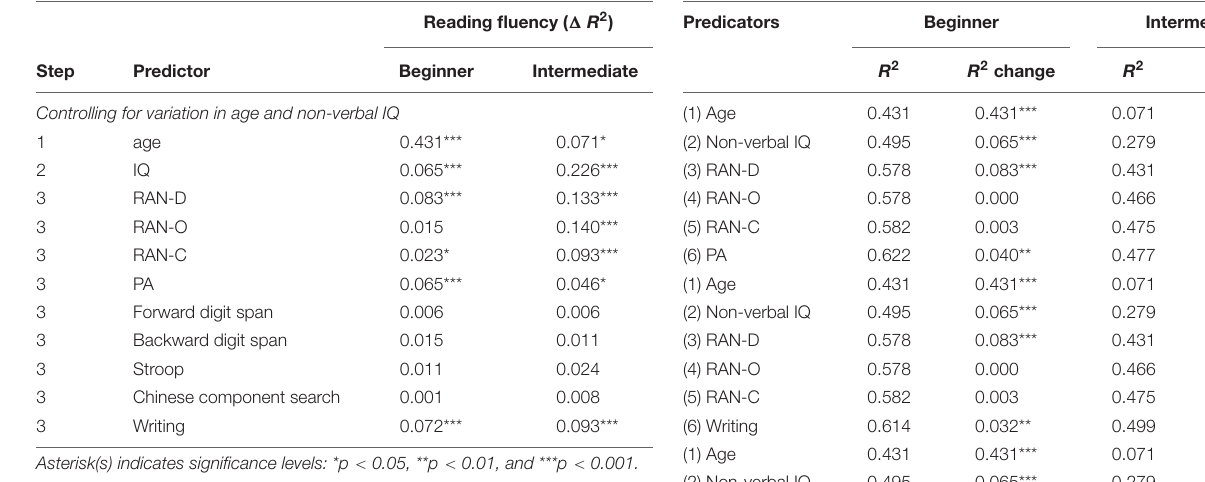
TABLE 3-1 | Summary of hierarchical multiple regressions that tested the predictive power of various component skill measures for reading fluency.